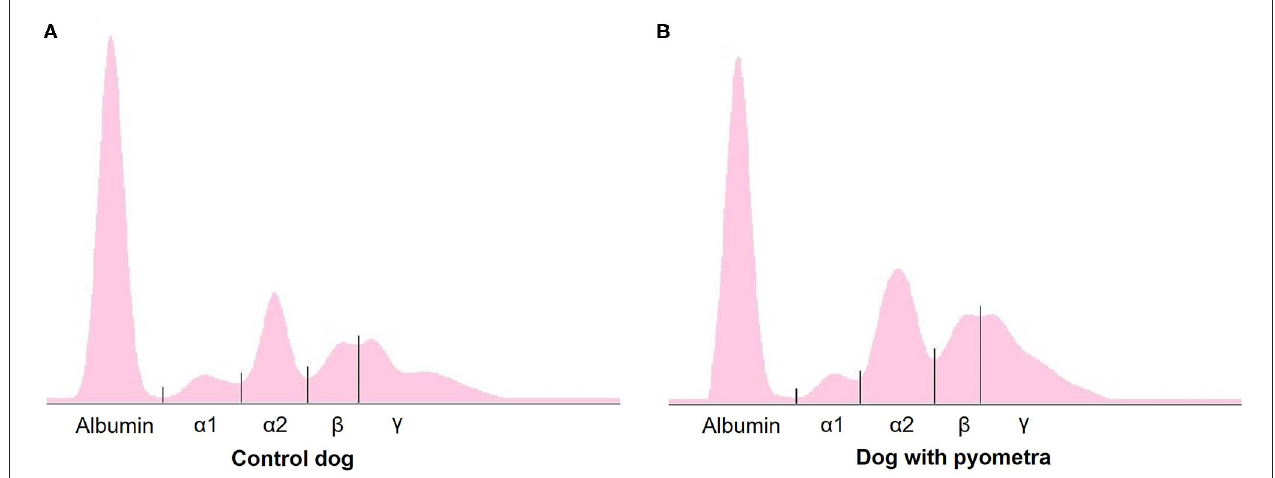
FIGURE 1 | A representative agar gel electrophoretogram in control dogs (A) and dogs with pyometra (B)